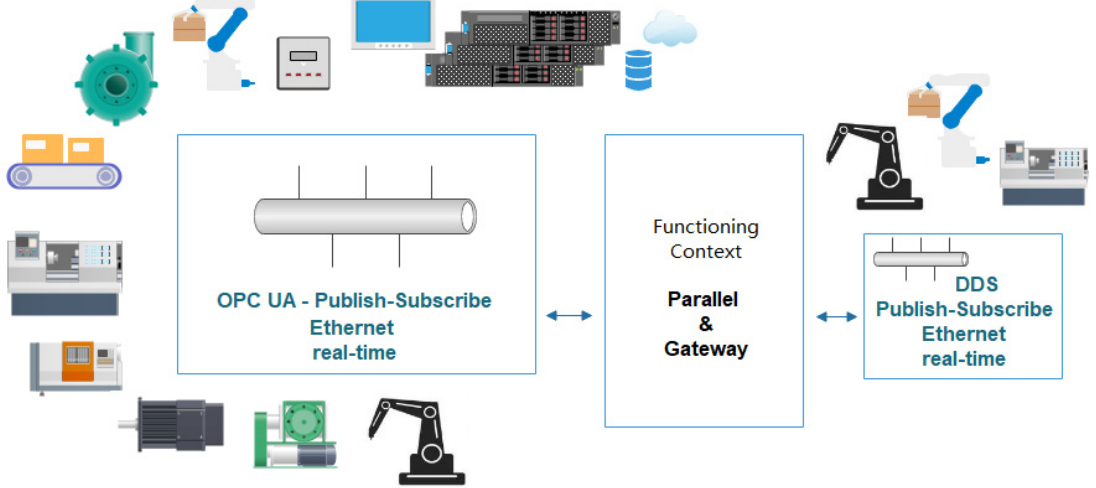
Figure 1. Schematic view of OPC UA—DDS protocol coexistence in the Industry 4.0 context.